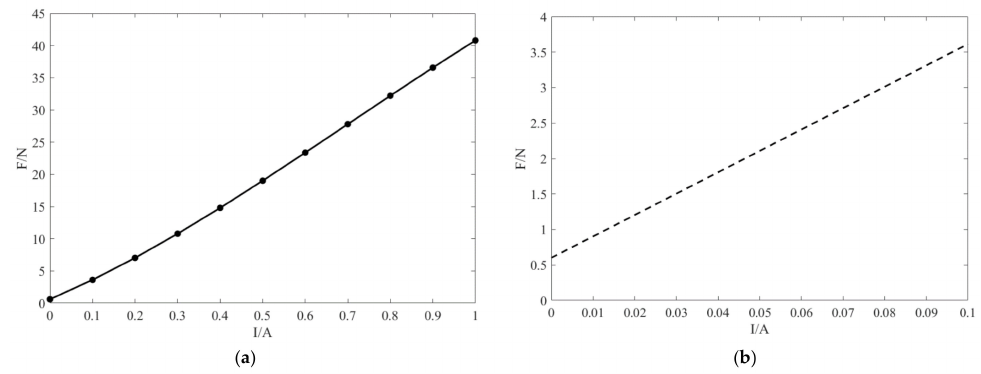
Figure 13. Relationship between the current and damping force: ( a ) full figure; ( b ) partial enlarged detail.